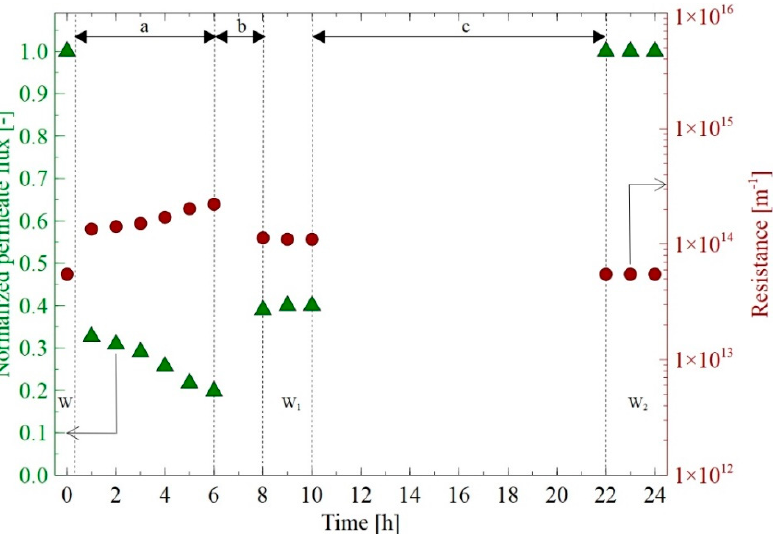
Figure 6. Changes in normalized permeate flux during the NF membrane run. a—NF of the fermentation broth, b—membrane rinsing, c—membrane soaking, W 1 , W 2 —measurements for distilled water.